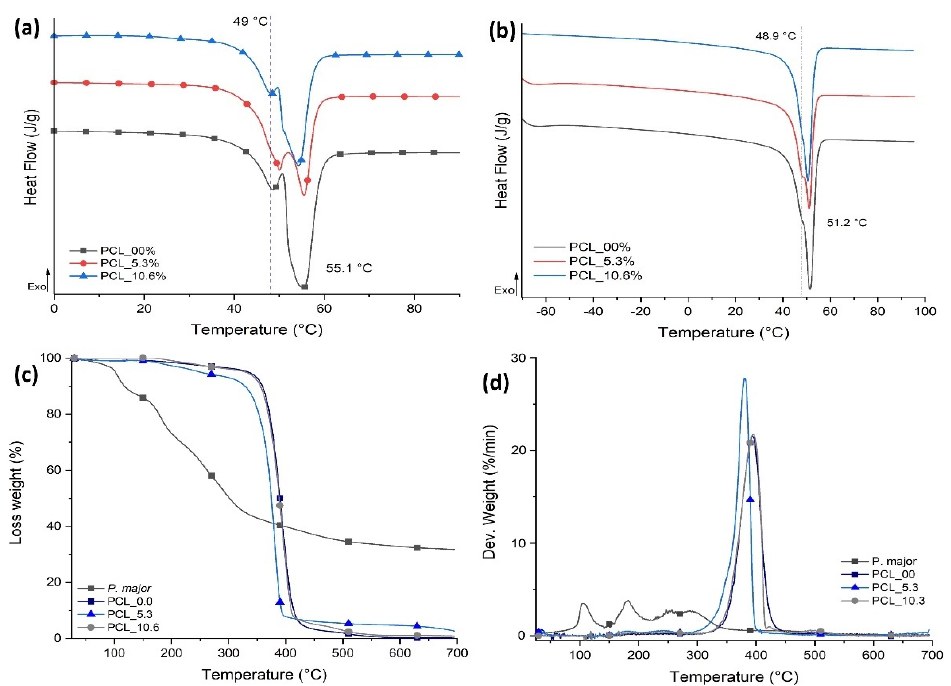
Figure 7. Thermal behavior PCL/ P. major electrospun samples: DSC curves for electrospun mats from PCL with different concentrations of P. major extract. ( a ) First heat cycle and ( b ) Second heat cycle; TG ( c ) and DTG ( d ) curves.